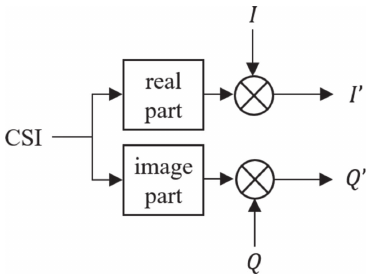
Figure 5. Schematic diagram of the internal structure of